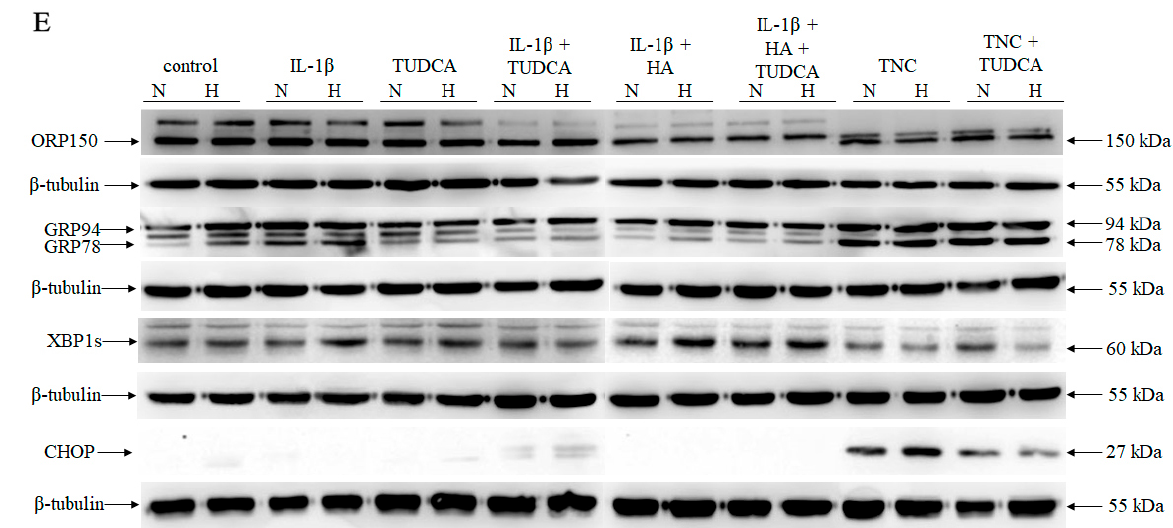
Figure 3. Expression of ER stress markers in NHAC-kn chondrocyte cells stimulated with IL-1 β , TUDCA, IL-1 β +TUDCA, IL-1 β +HA, IL-1 β +HA+TUDCA, TNC, and TNC+TUDCA for 72 h. Relative quantification of Orp150 ( A ), Grp78 ( B ), Xbp1 ( C ), and Chop ( D ), expressions in normoxic and hypoxic conditions. Results of qRT-PCR are shown as relative fold change in mRNA expression in comparison to untreated controls, where expression level was set as 1. Protein expressions of ORP150, GRP78, GRP94, XBP1s, and CHOP ( E ). Representative Western blot images are shown. β -tubulin was used as the loading control. Results of qPCR analysis are presented as mean ± SD from three independent experiments run in triplicate. Significant changes are expressed relative to controls and marked with asterisks and hashes placed above the columns, or as specifically indicated with dashes linking compared treatments. Statistical significance was considered if * p < 0.05 or # p < 0.001.